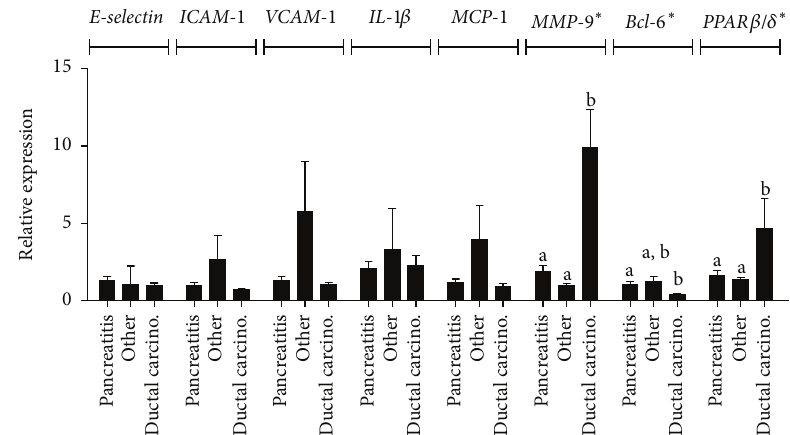
Figure 1: Relative mRNA expression in human pancreatic tissues at varying stages of carcinogenesis from chronic pancreatitis to pancreatic cancer. Total mRNA was isolated using standard Tri-Reagent protocol and reverse-transcribed. Gene expression was determined using qRT- PCR and expressed as fold induction after normalization to 𝛽 -actin . ∗ 𝑃 < 0.05